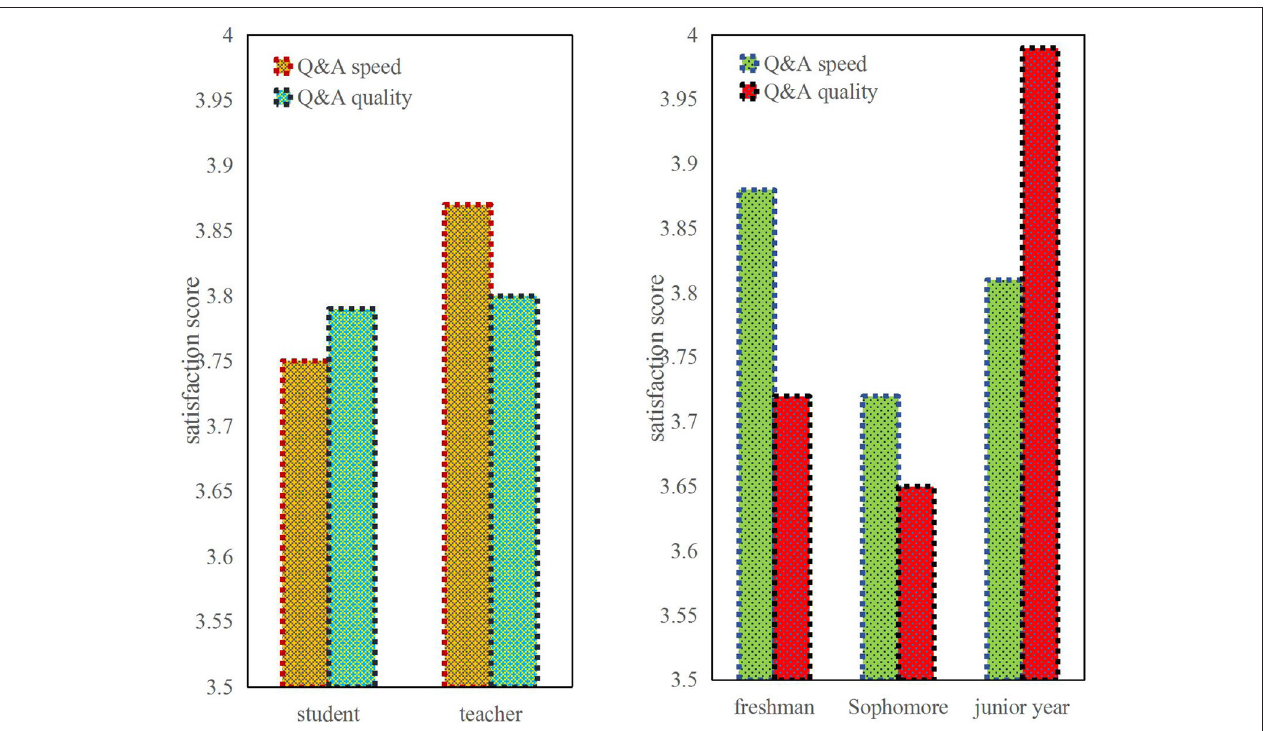
FIGURE 2 | Comparison of satisfaction with teacher-student interaction among different